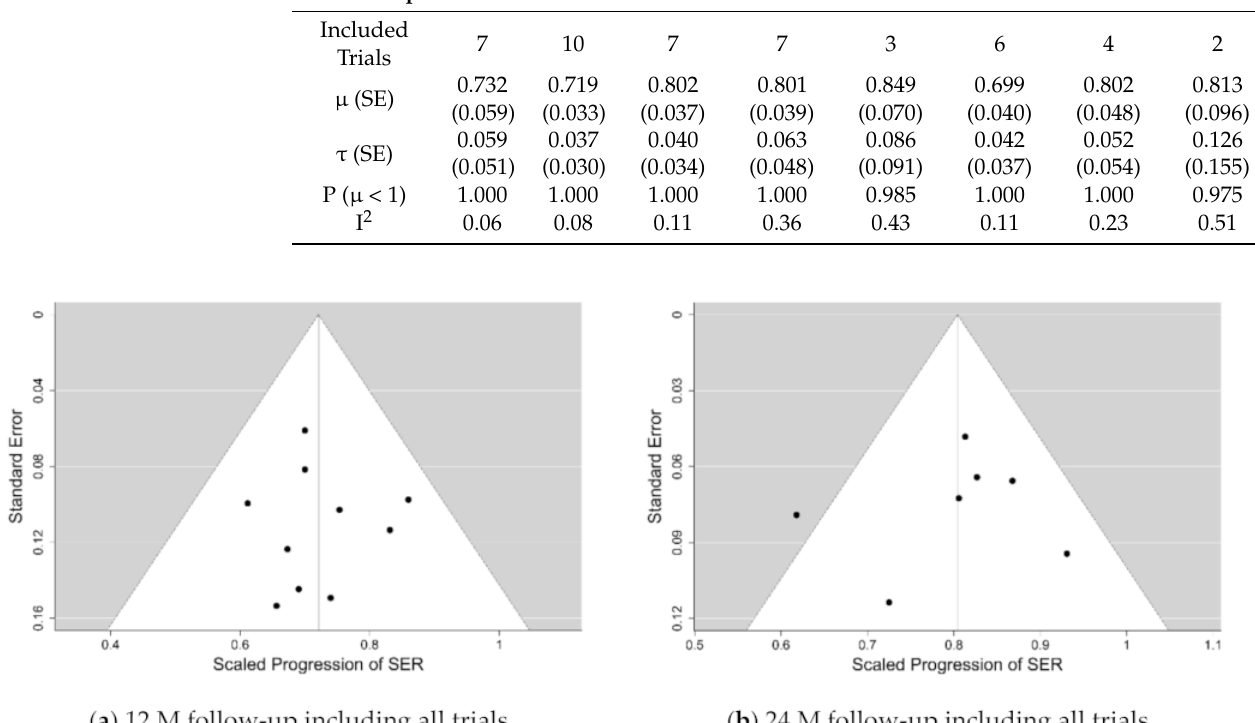
Figure 1. Funnel plots for the primary variable in progressive spectacle lens meta-analysis—the scaled progression of sphere equivalent refraction (SER) at the 12-months and 24-months follow-ups with all trials included ( a , b ), respectively). The vertical line at the centre marks the mean effect size of all trials, the sides of the funnel mark the 95% credibility interval, and the dots correspond to individual intervention